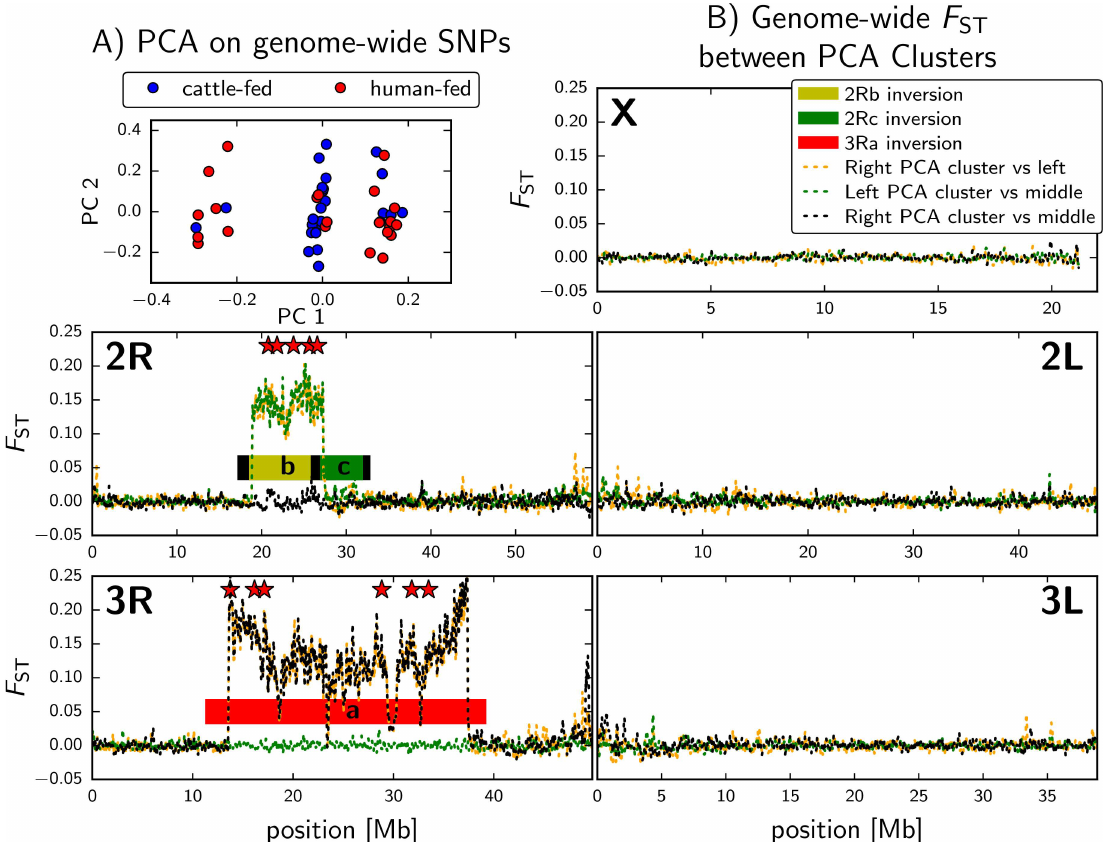
Fig 2. Geneticvariationexplainedby the 2Rb and 3Ra inversions. a) Geneticstructurewas assessed using genome-wide SNP data for individual An . arabiensis females using a PCA analysis. ThreediscretePCA clusterswere observed. Red = human-fed and blue = cattle-fed. Thereis an enrichment of cattle-fed individuals in the middlePCA cluster (P < 0.001; FisherExact).(b) To reveal differentiated genomicregionsunderlyingthe distinctPCA clusters (left,middle, and right)we plottedF ST for each chromosome in 100kb windows with 20kb steps betweenthe PCA clusters. The outsidePCA clusters differed at the 2Rb and 3Ra inversions (orange),left versus middlePCA clustersdiffered at 2Rb only (green),and rightversus middlediffered at 3Ra only (black). Stars indicatethe position of SNPs chosen for the inversion genotyping assay.